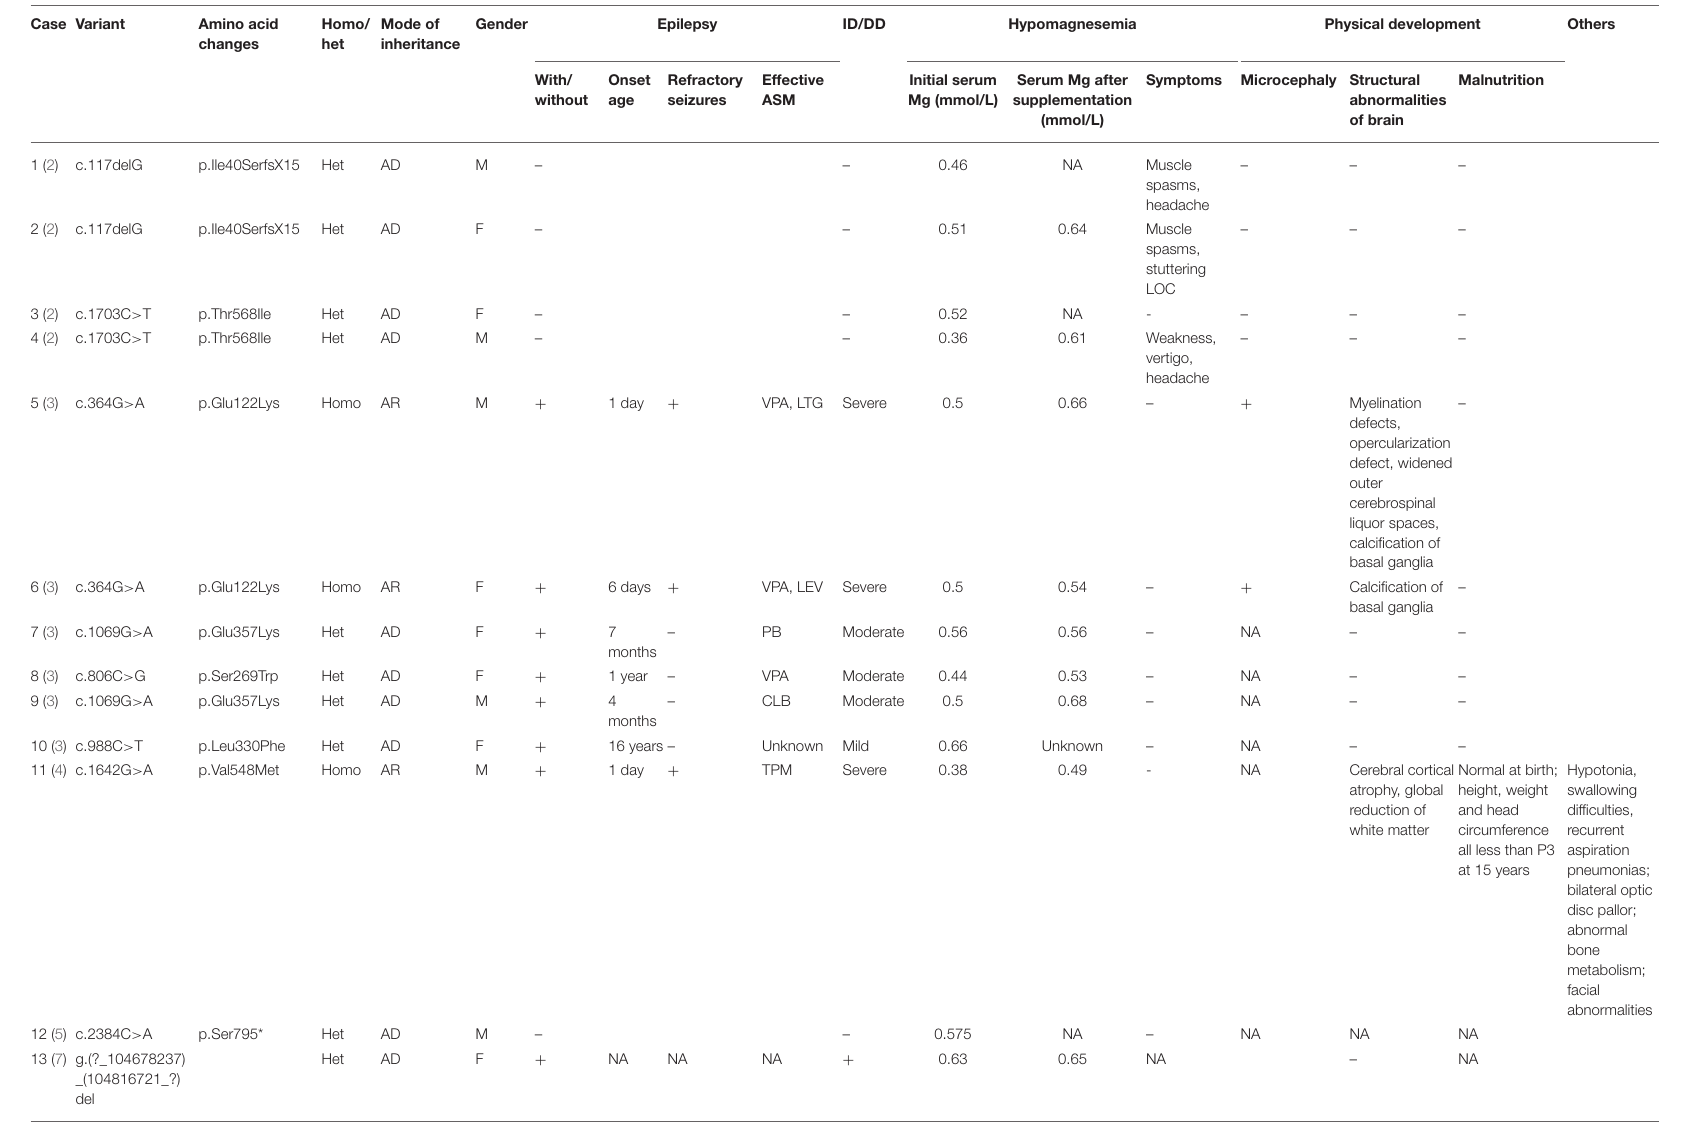
TABLE 2 | The variants and clinical phenotypes of patients with CNNM2 -related